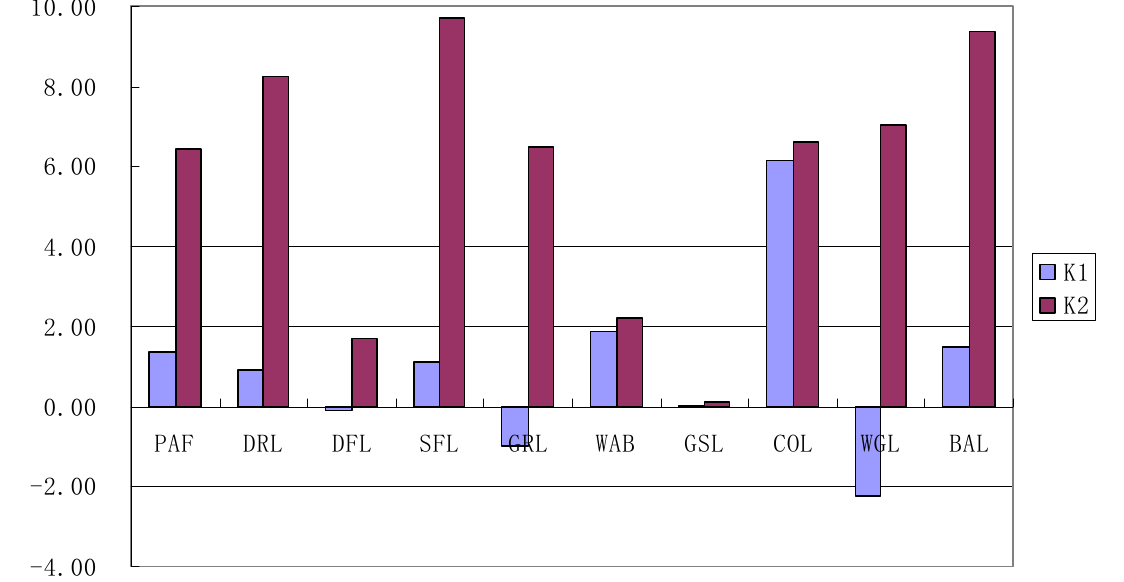
Figure 5. Change rate of single land use type in Lijiang County during